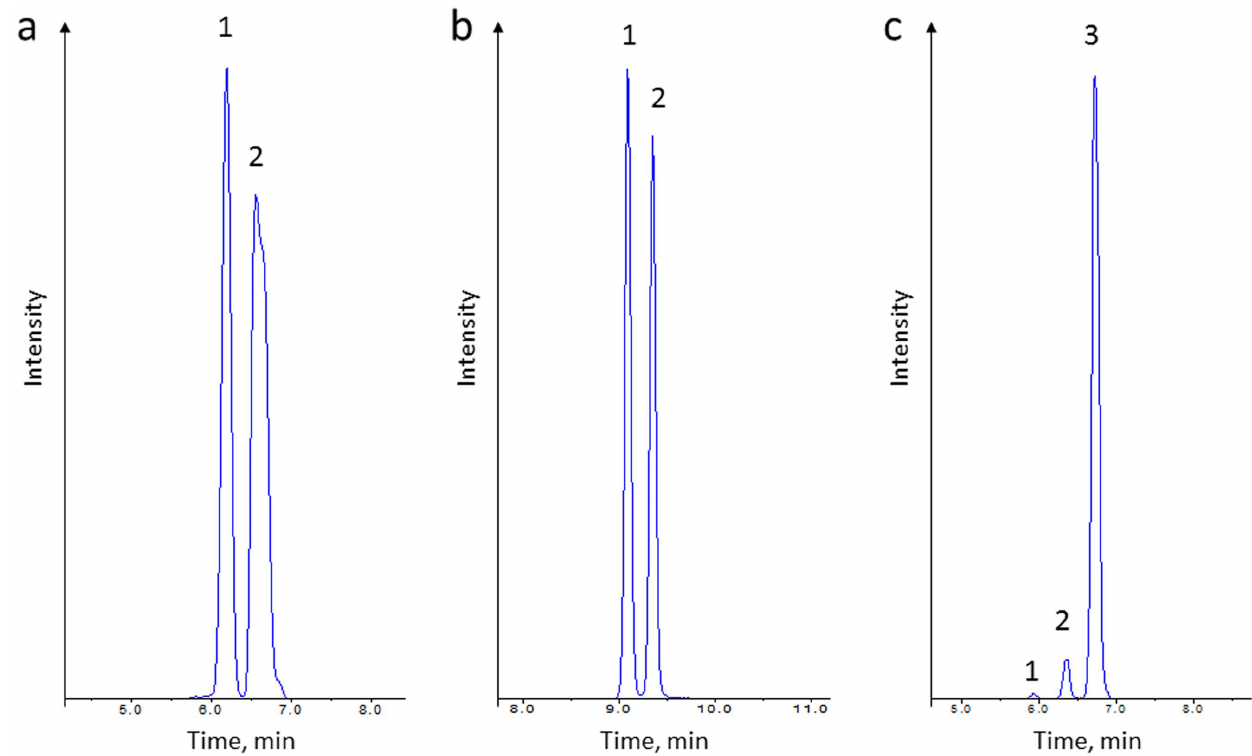
Figure 1. Extracted ion chromatograms of isobaric amino acids acquired during the analysis of one of the serum sample. a: identified amino acids: 1-1MHis; 2-3MHis; b: identified amino acids: 1-Val; 2–Nval; c: identified amino acids: 1-Sar; 2-bAla; 3–Ala.